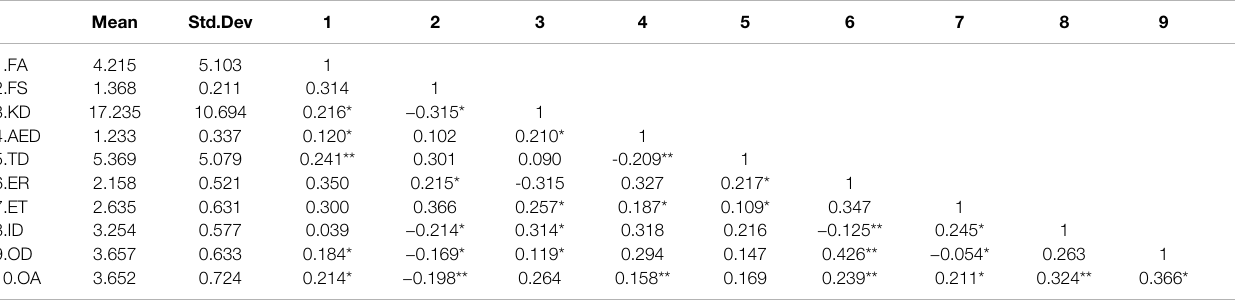
TABLE 3 | The means, standard deviations, and Pearson coef fi cients of the variables.